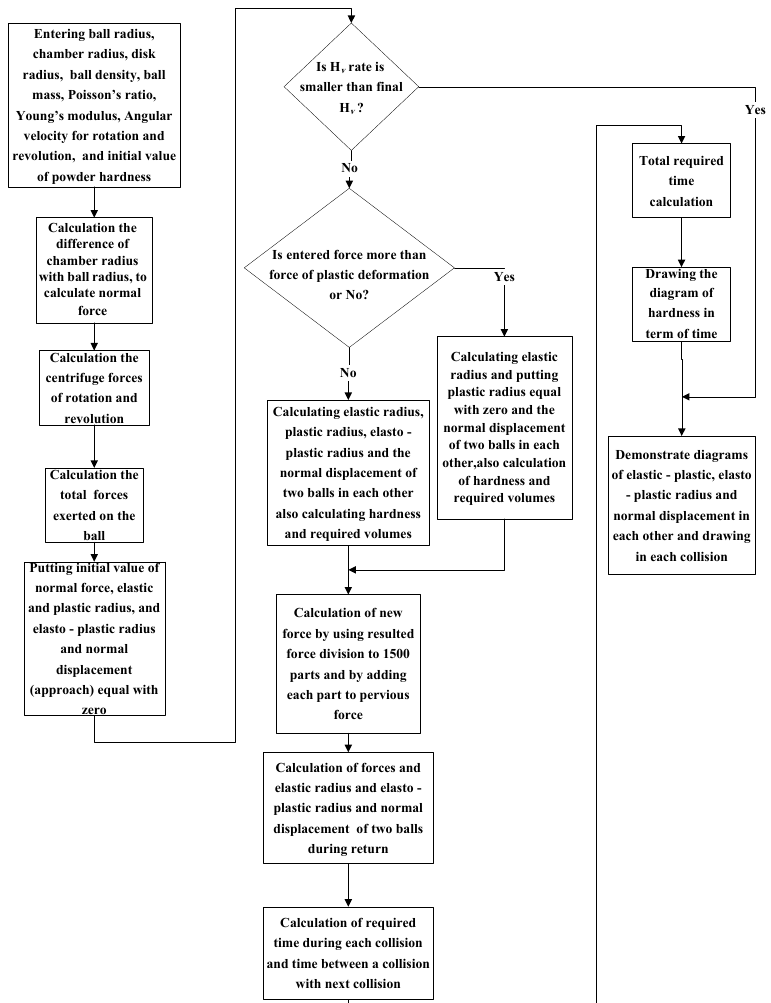
Fig. 1. Box diagram of calculating the powder hardness during BM